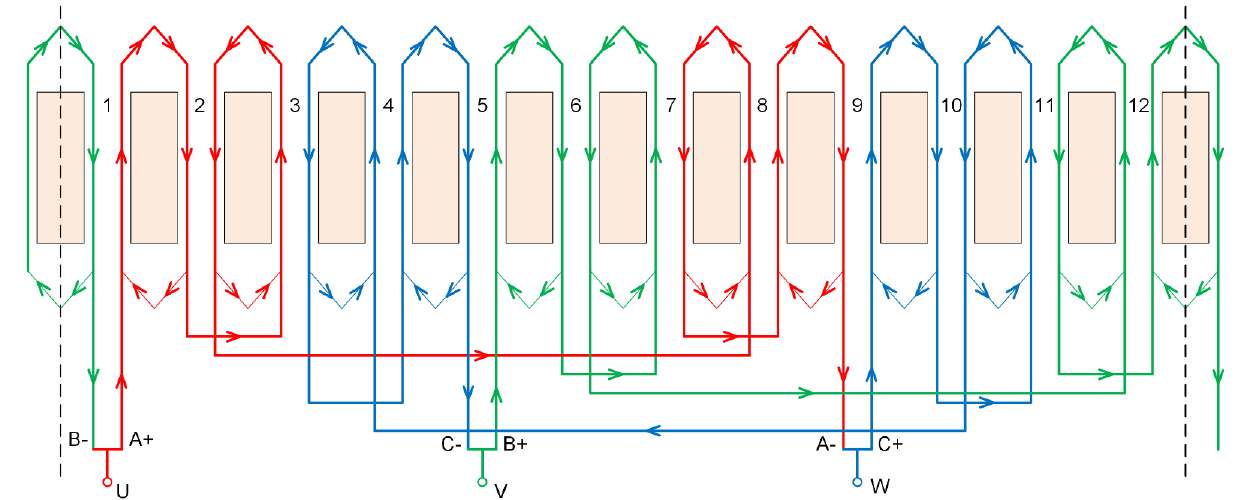
Figure 2. Shimano Steps motor winding layout.